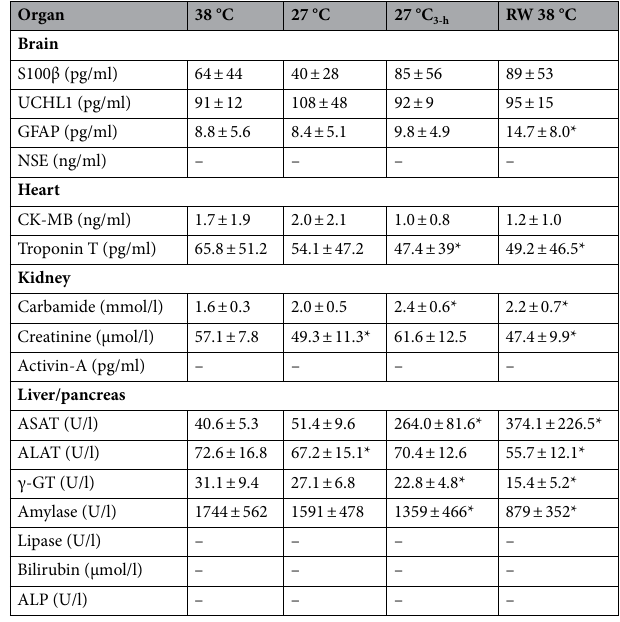
Table 3. Serum biomarkers for organ function and organ injury. UCHL1, Ubiquitin Carboxyl-terminal Esterase-L1; GFAP, Glial Fibrillary Acidic Protein; NSE, Neuron-Specific Enolase; CK-MB, Creatine Kinase- Muscle/Brain isozyme; ASAT, Aspartate Aminotransferase; ALAT, Alanine; Aminotransferase; γ-GT, γ-Glutamyl Transpeptidase; ALP, Alkaline Phosphatase. n = 8, values are mean and SD. * p < 0.05 statistically significantly different from baseline value.—indicate serum level below lower level of